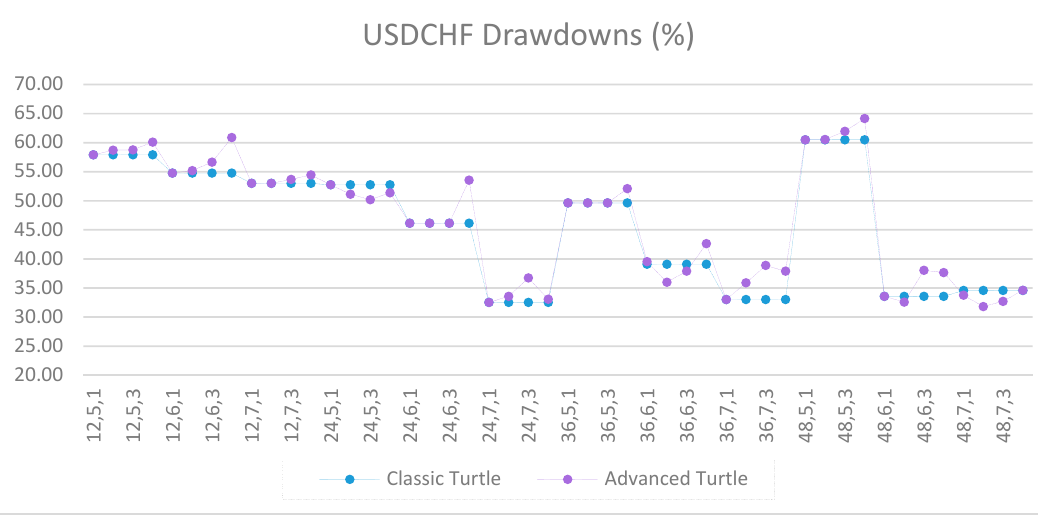
Figure A56. Drawdowns of USDCHF as percentage of equity between the classic and the advanced Turtle systems for every combination of N, X, Y for the slow parameters (80, 160), where X ≥ 5.